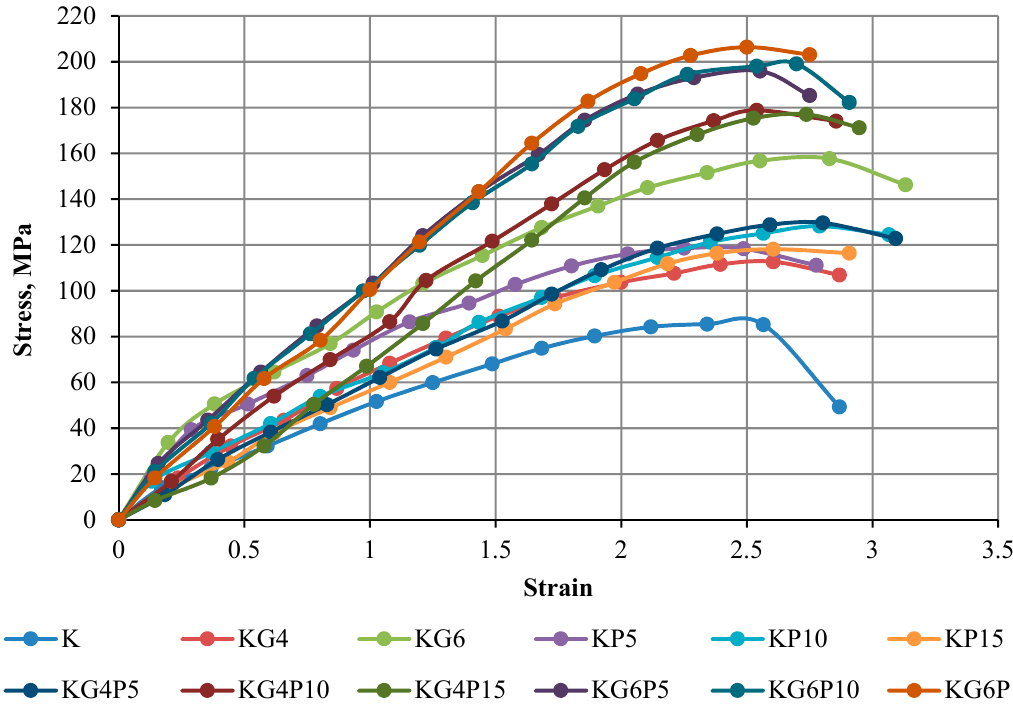
Figure 6. Stress–strain curve of kaolin and treated kaolin with gypsum and POFA tested after 1 day of curing.